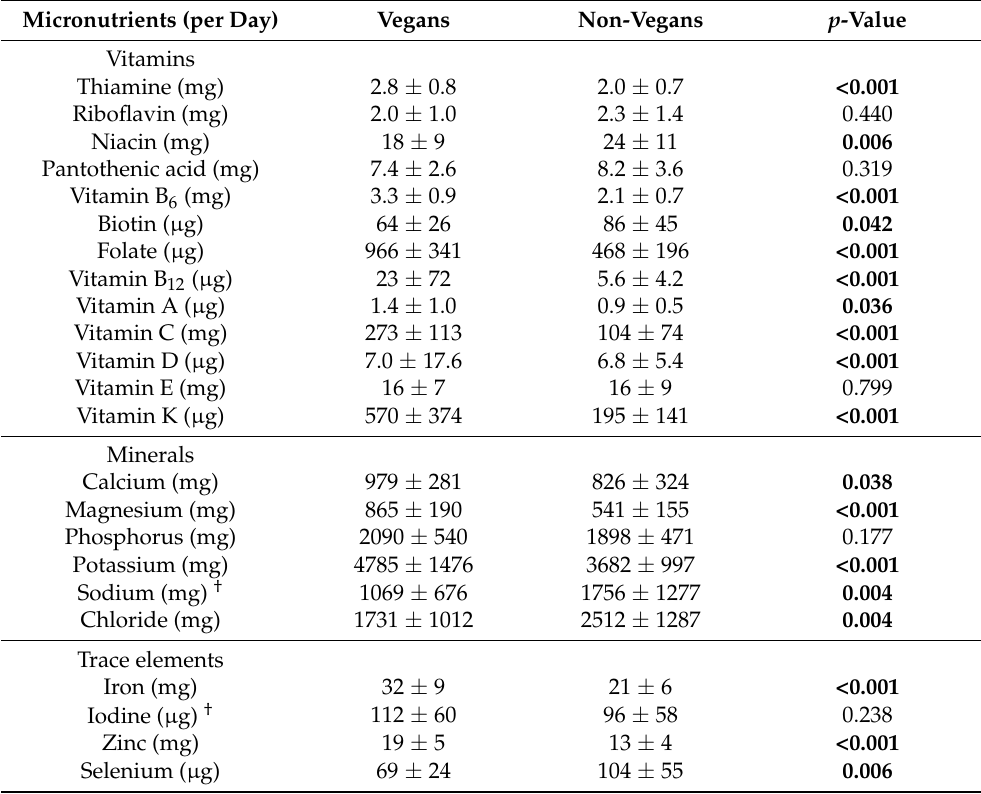
Table 3. Intake of selected vitamins, minerals, and trace elements. Micronutrients (per